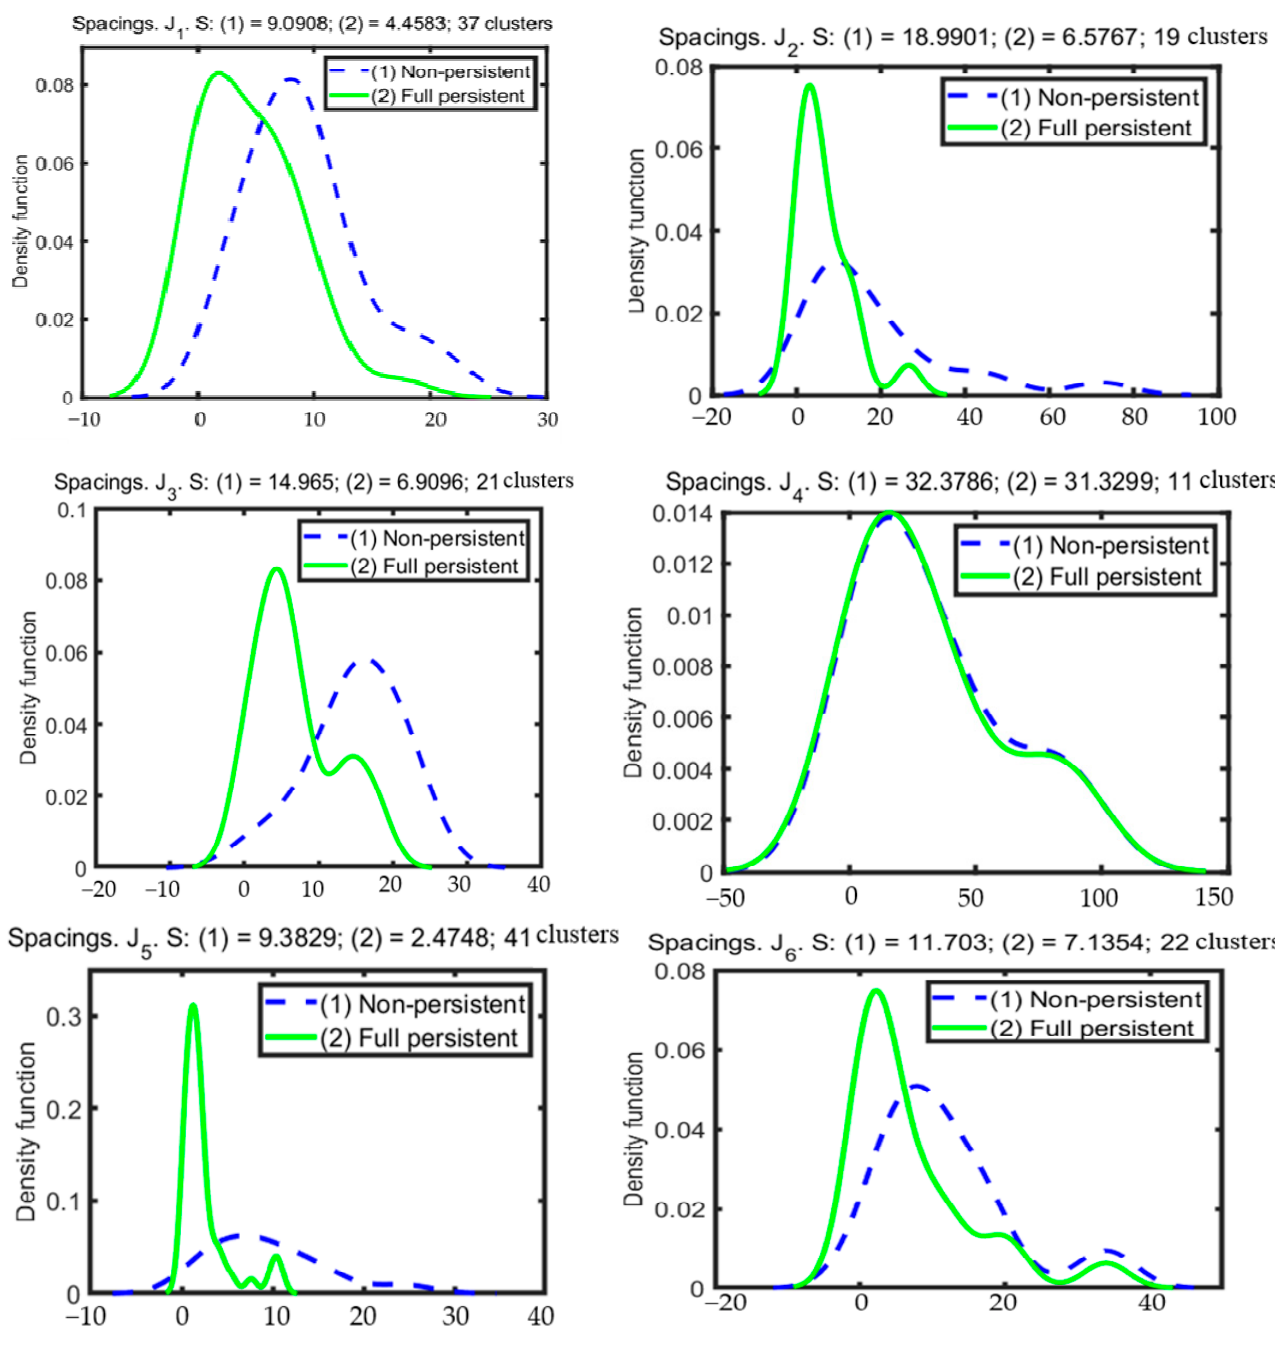
Figure 17. Discontinuity spacing of rock mass. Table 4. Summary of the distance between discontinuous planes in each group of cliff